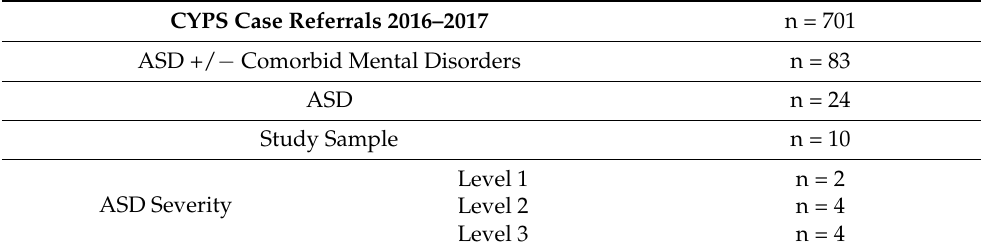
Table 1. Phase 1; The Selection Process. CYPS Case Referrals